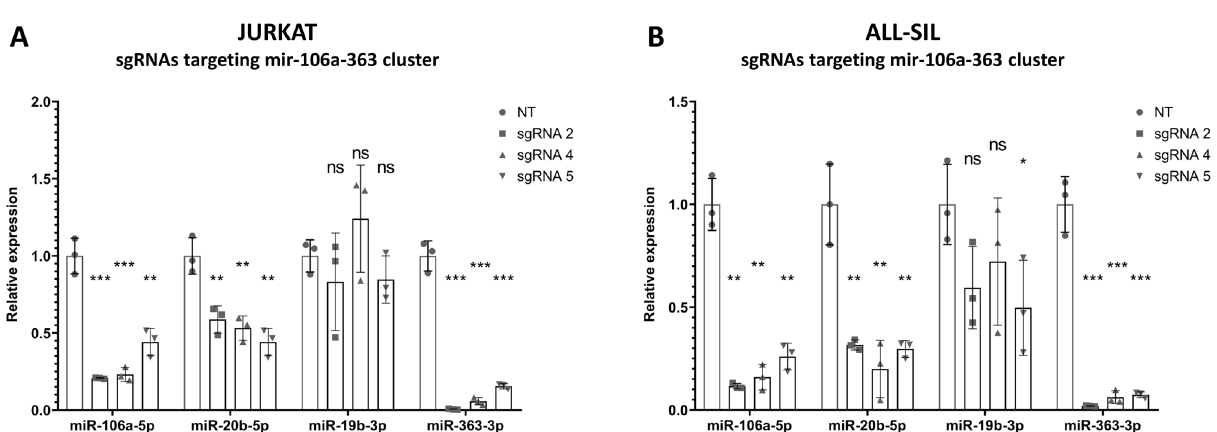
Figure 4. Expression of miRNAs encoded within mir-106a-363 cluster upon dCas9-KRAB-mediated inhibition of this locus. ( A ) Normalized expression of miR-106a-5p, miR-20b-5p, miR-19b-3p and miR-363-3p upon the use of three most effective sgRNAs targeting putative TSS of mir-106a-363 cluster in JURKAT cell line. ( B ) Normalized expression of miR-106a-5p, miR-20b-5p, miR-19b-3p and miR-363-3p upon the use of three most effective sgRNAs targeting putative TSS of mir-106a-363 cluster in ALL-SIL cell line. Scr—scrambled control. * p < 0.05; ** p < 0.01; *** p < tor targeting miR-20b-5p (Supplementary Fig. S8B) resulted in effective blocking of target miRNA but also of miRNA with high sequence homology (miR-20a-5p). Next, we compared the effectiveness and specificity of CRISPRi and shRNA-inhibition towards miRNAs with high sequence homology, but not encoded in paralogous clusters. We analyzed the expression of two miRNAs, hsa-miR-130a-3p and hsa-miR-130b-3p, (encoded on chromosomes 11 and 22, respectively) in JURKAT and ALL-SIL cell lines, upon the use of CRISPRi as compared to shRNA-mediated repression (using miRZip miRNA